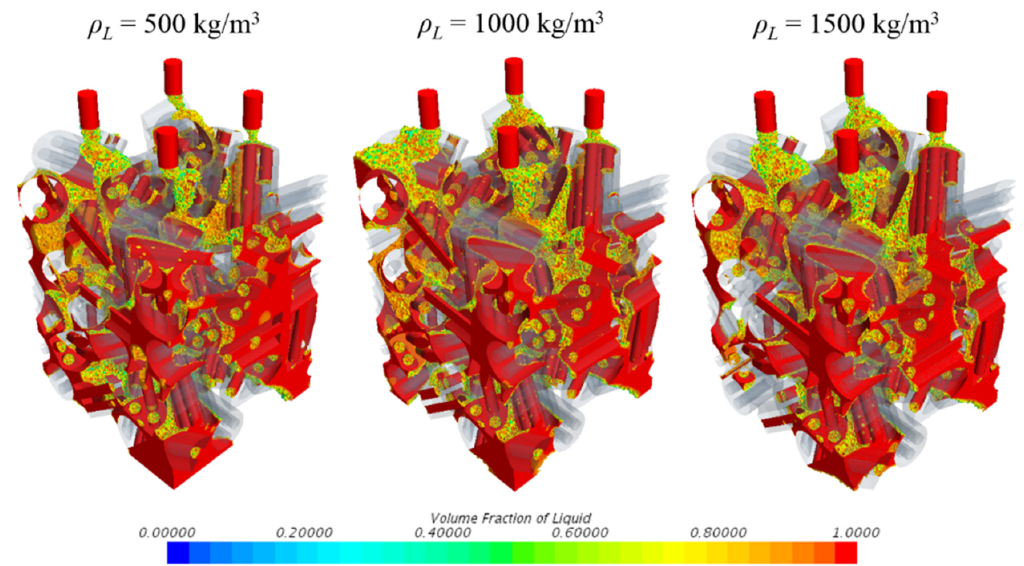
Figure 8. Liquid distributions with three liquid densities ( v G = 0.245 m/s, v L = 0.008 m/s).